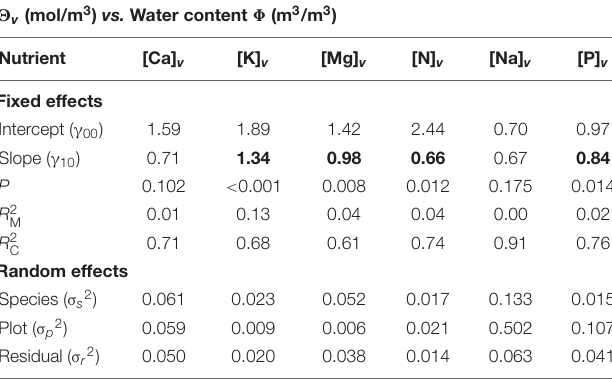
TABLE 3 | Mixed effect modeling of the relationships between nutrients expressed on a tissue volume basis ( (cid:50) v ) and water content ( (cid:56) ). (cid:50) v (mol/m 3 ) vs. Water content (cid:56) (m 3 /m 3